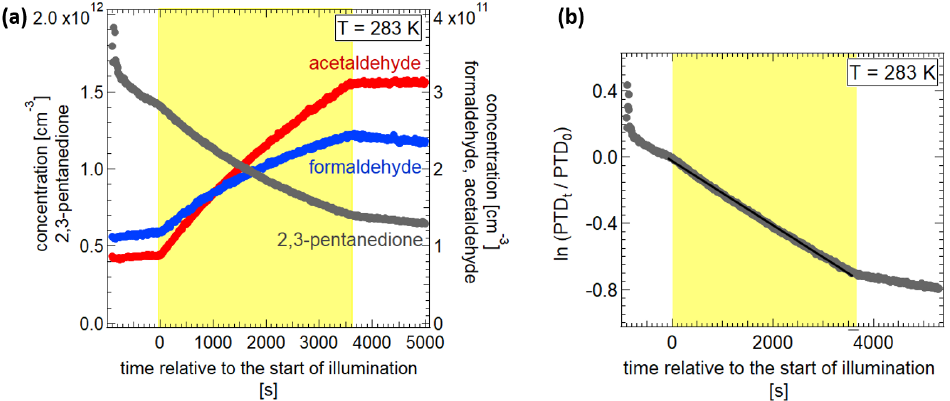
Figure 5. (a) Concentrations of 2,3-pentanedione, acetaldehyde and formaldehyde during the experiment. (b) Logarithmic depiction of the 2,3-pentanedione (PTD) concentration to calculate the photolysis frequency.